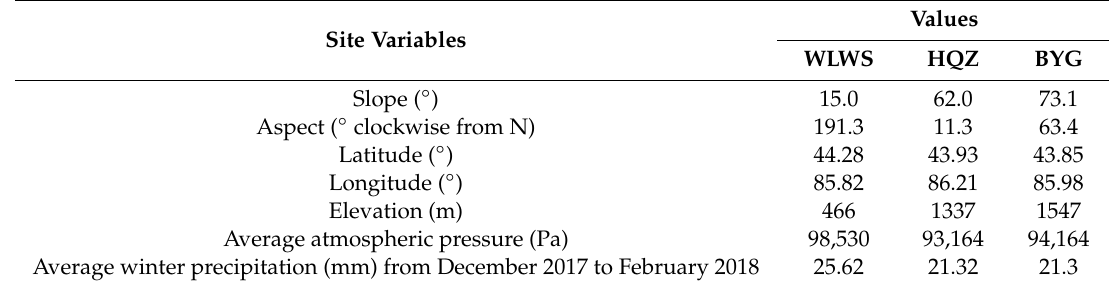
Figure 1. Map of the study area and locations of the three automatic snow and weather stations used in this study. Photos are also shown for the Wulanwusu (WLWS), Hanqiazi (HQZ), and Baiyanggou (BYG) stations. Table 1. Site parameters of the three automatic snow and weather stations.